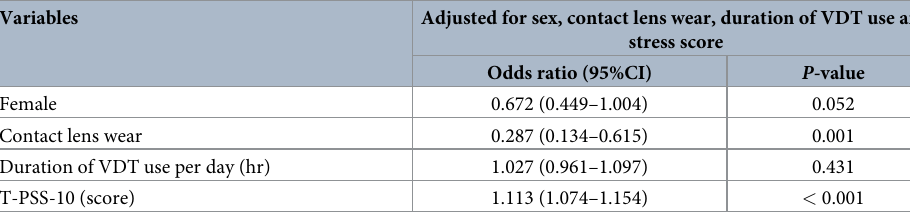
Table 3. Regression analysis for factors associated with increasing severity of